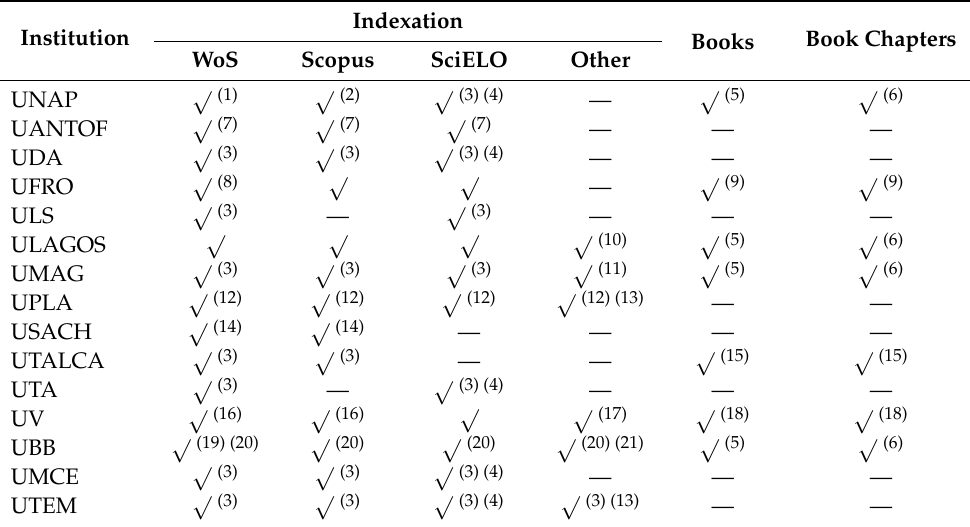
Table 2. Type of scientific publications subject to productivity